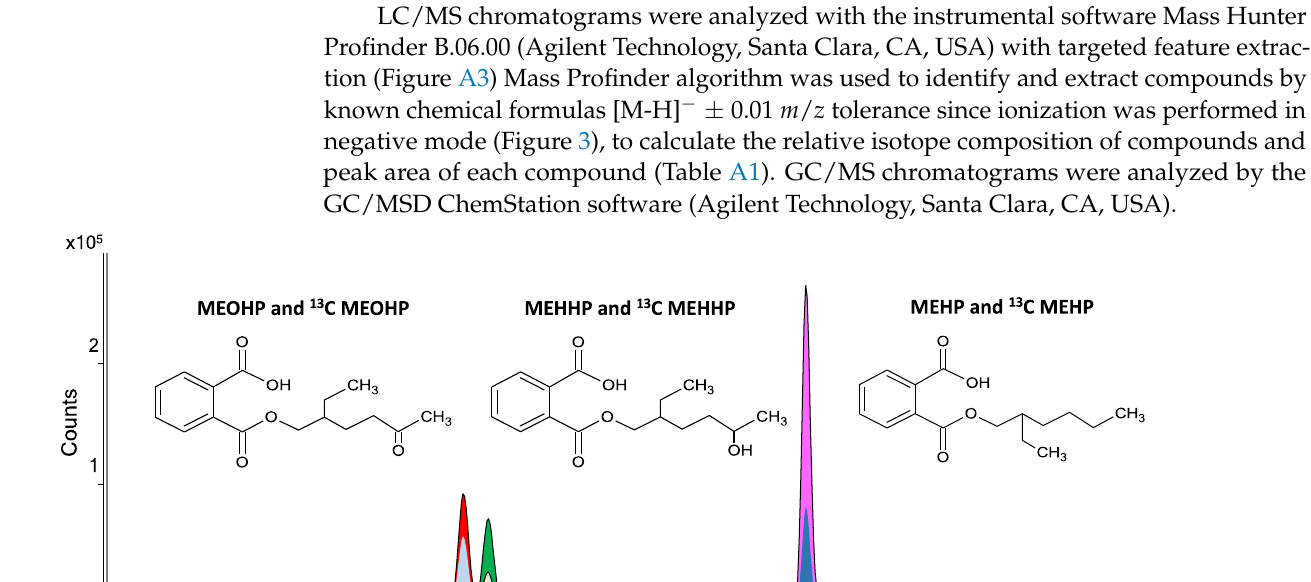
Table 3. Recovery of DEHP metabolites and BPA in blank and urine samples.